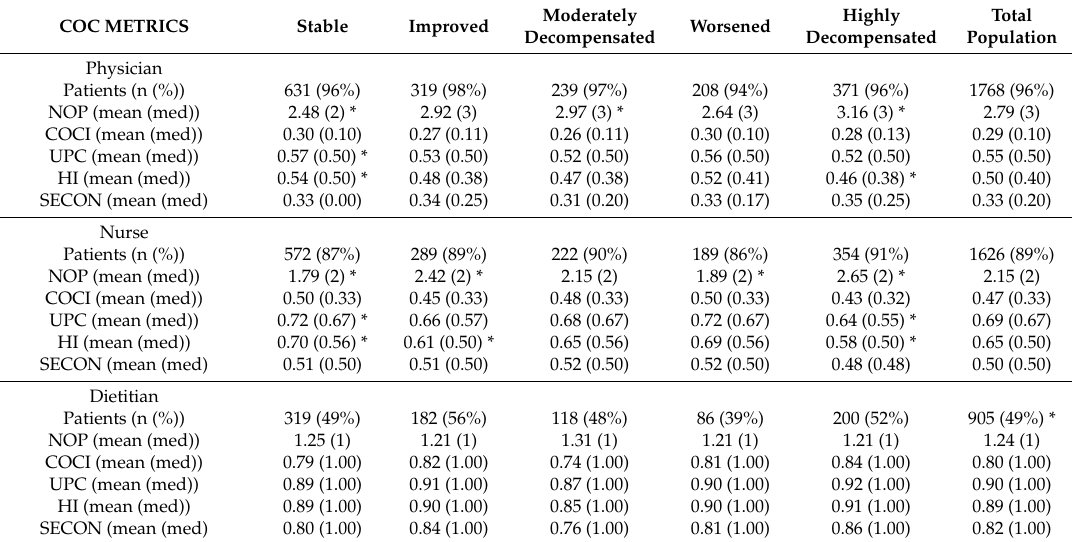
Table 4. Continuity of care indices for segments and total